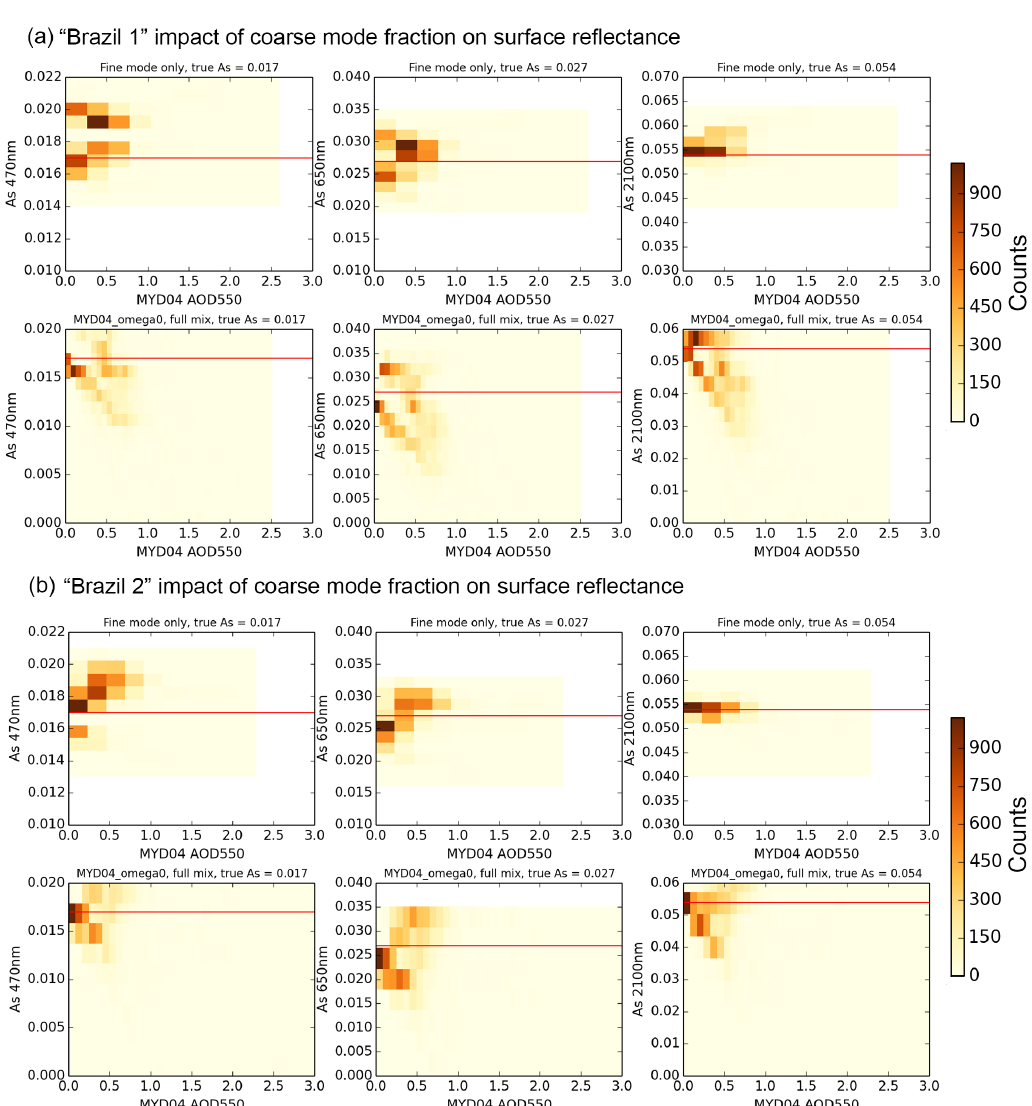
Figure 11. Impact of coarse-mode fraction on MOD04-retrieved surface reflectance. Set (a) shows the Brazil 1 case and set (b) shows Brazil